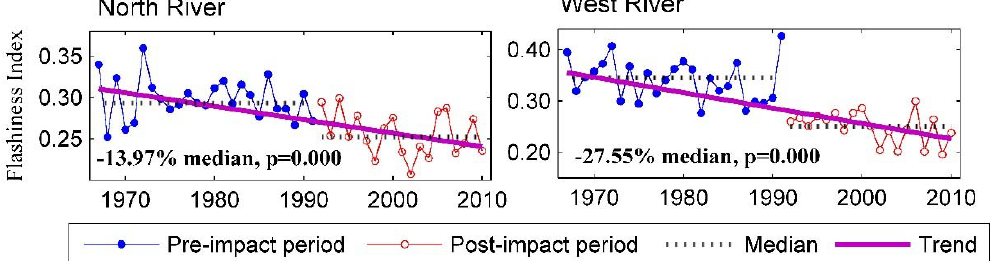
Figure 2. Temporal trend of flashiness index during 1968–2010 (modified from Huang et al., 2013).